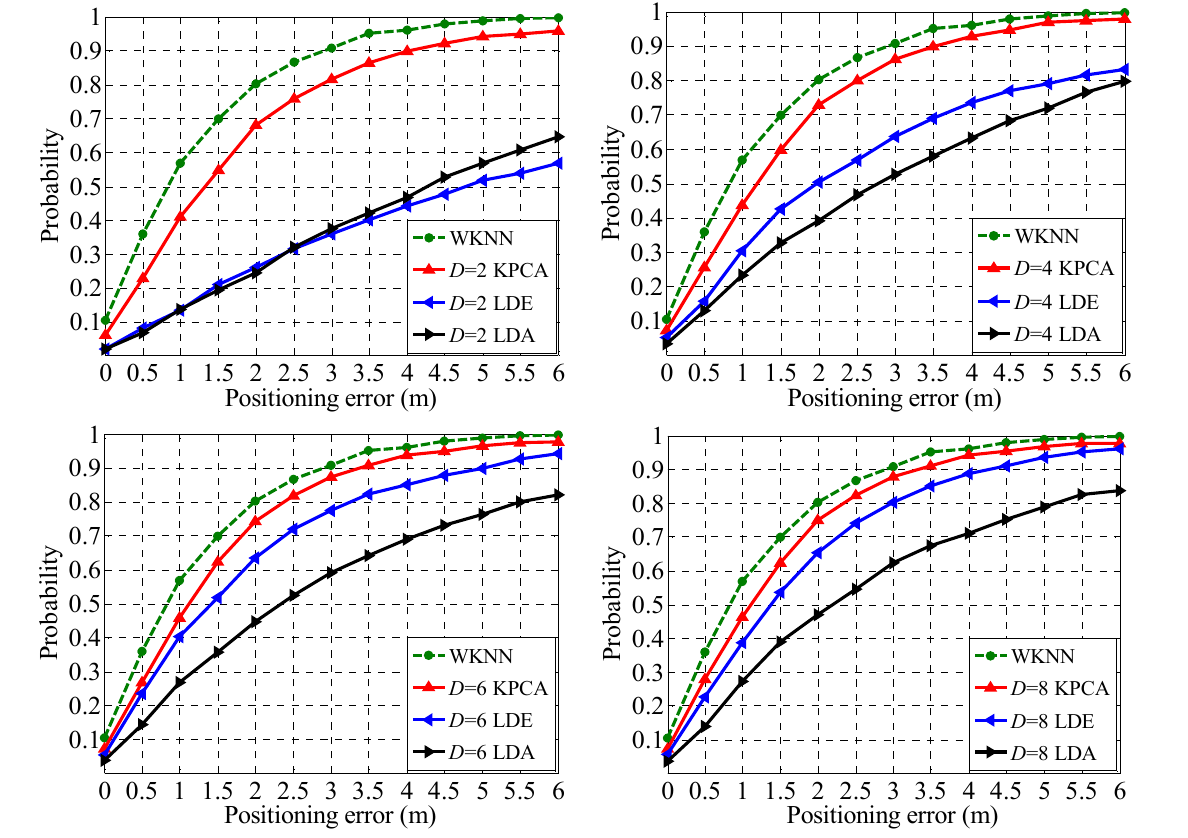
Figure 11. Positioning accuracies comparison between methods in the cases of D = 2, D = 4, D = 6 and D = 8,